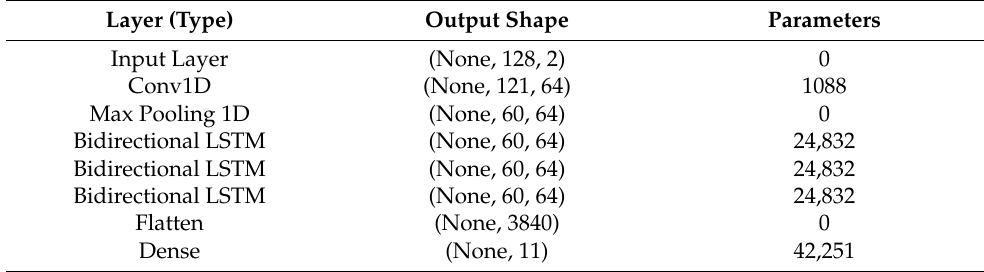
Table 8. Architecture of